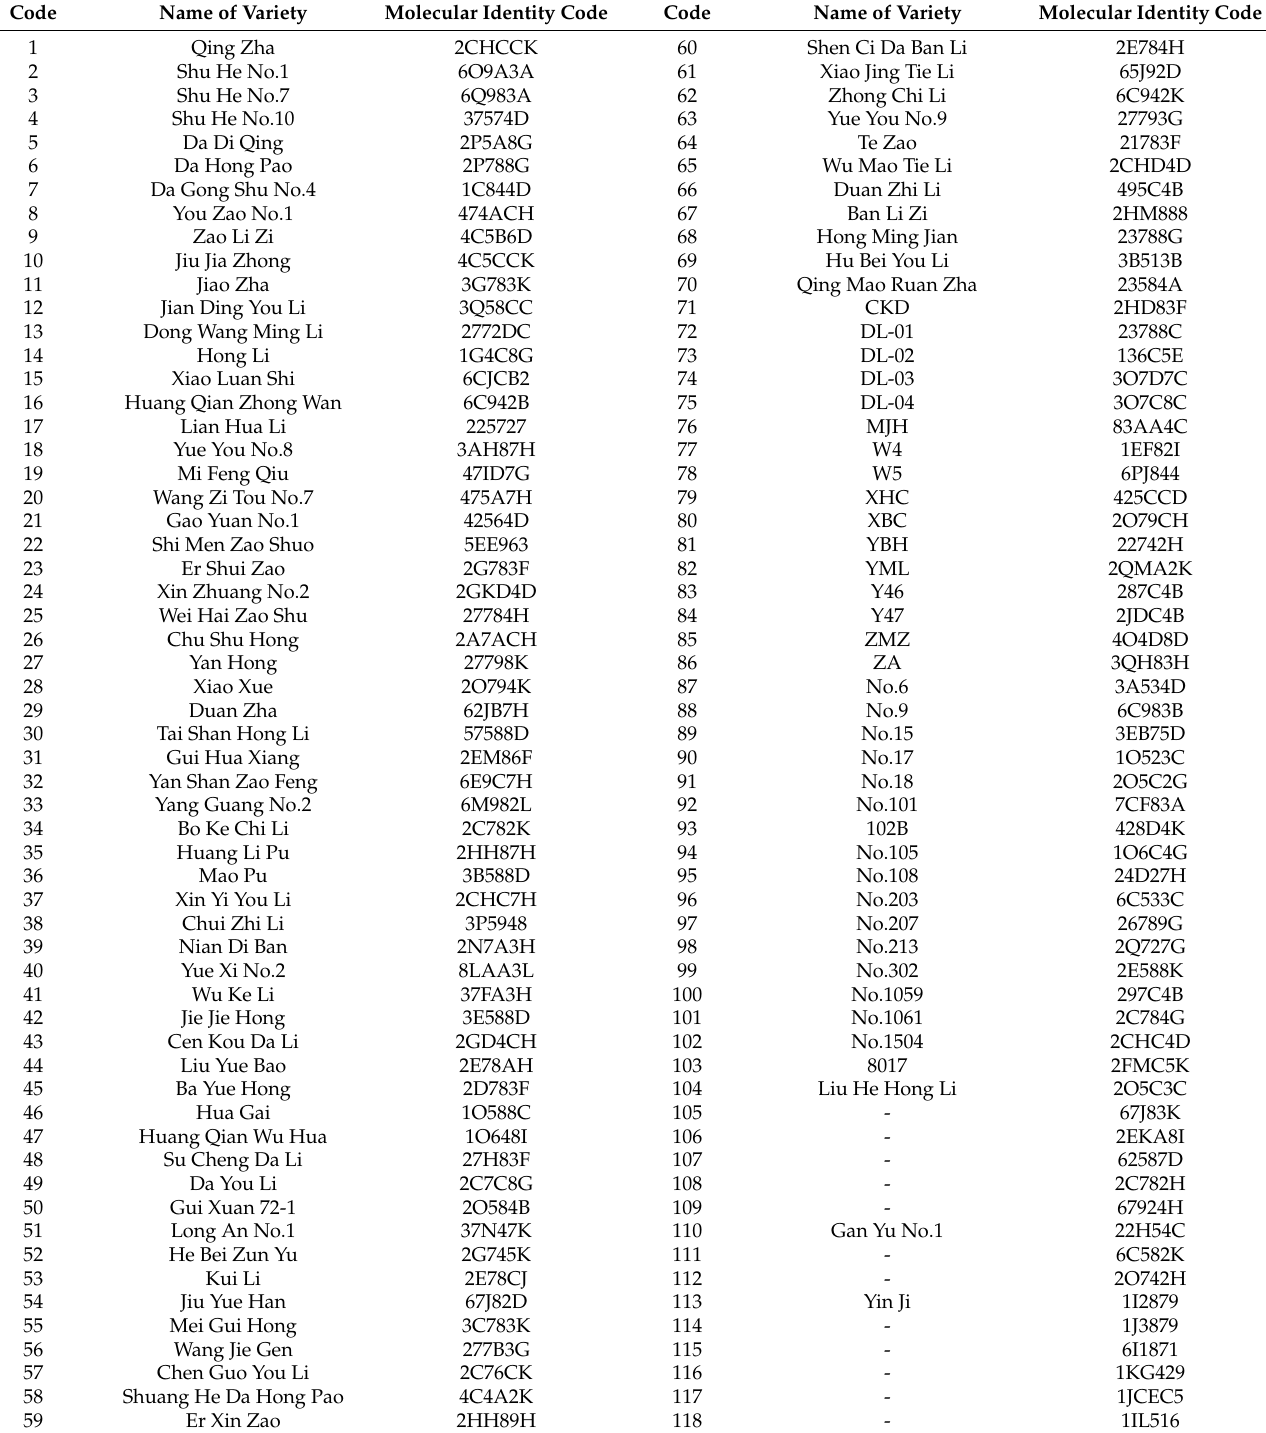
Table 4. Six-digit molecular ID codes of 118 Castanea plant